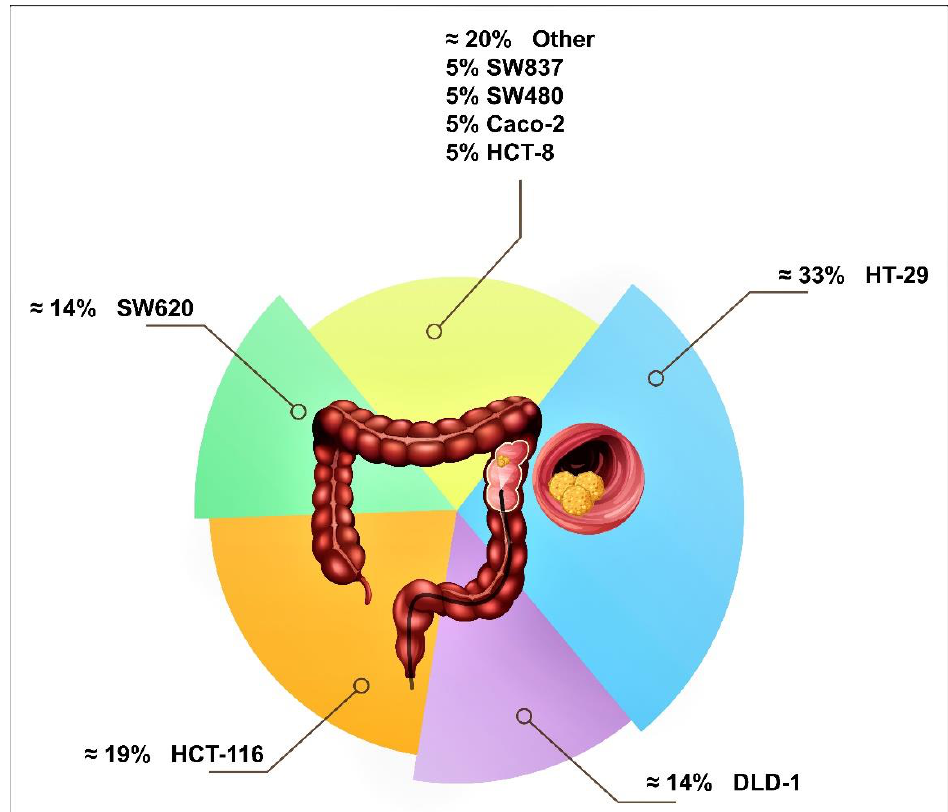
Figure 3. Pie chart showing the relative distribution of the commonly used human colorectal carcinoma (CRC) cell lines as a cell-based model of CRC. These eight human CRC cell lines represent most of the human CRC cell lines used in the 12 research articles selected for this scoping review. Micrographs (Scale bar: 100 μm).